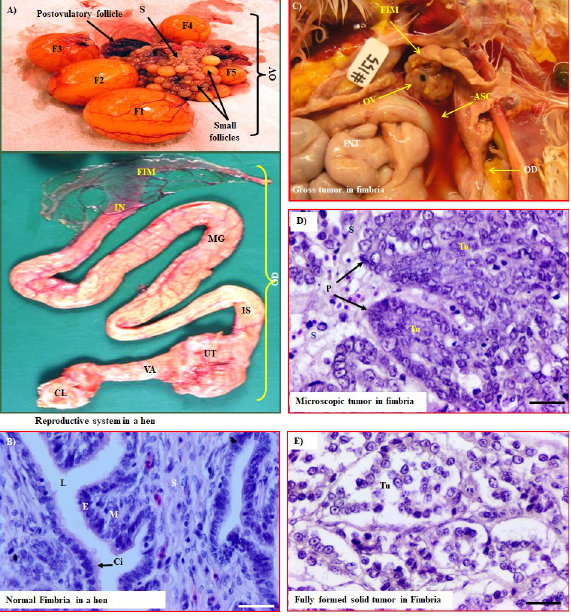
Fig 2. Spontaneous malignant transformation of chicken oviductal fimbria. A) Gross presentation of the reproductive system in a hen showing the ovary and different parts of the oviduct including oviductal fimbria (FIM), infundibulum (IN), magnum (MG), isthmus (IS), uterus (UT), vagina (VA). B) Microscopic presentation of chicken normal fimbria showing morphological similarities with that of human. C) Gross presentation of fimbrial tumor at early stage accompanied with ascites (ASC). D) Section of a microscopic tumor in fimbria showing papillary-like structure (P). E) Section of a fully formed tumor in fimbria. Ci = Cilia, CL = Cloaca, E = Surface epithelial layer, F 1 to F 5 = Hierarchical follicles, INT = Intestine, L = Lumen, M = Mucosa in fimbria, OV = Ovary, OD = Oviduct, S = Stroma, Tu = Tumor. Scale bar = 20 μ m.